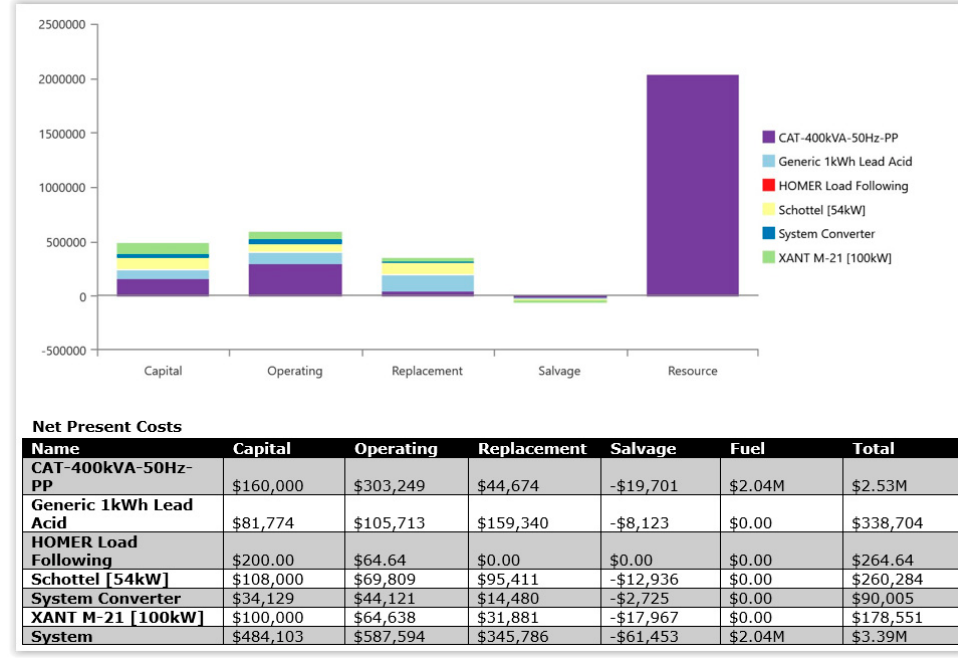
Figure 17. Cost summary and components of scenario with lowest NPC (2W + 2T).